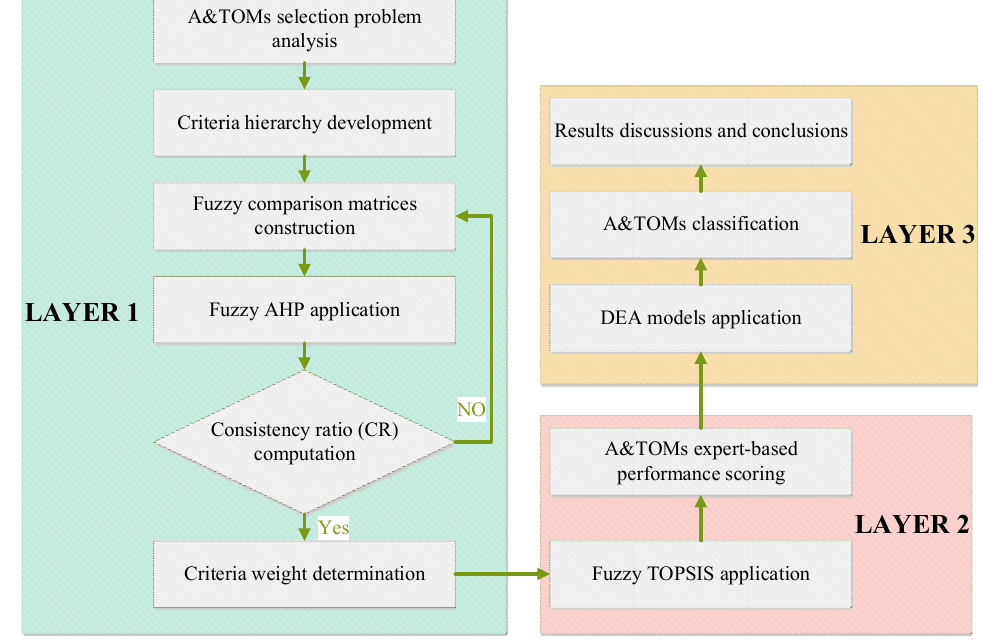
Figure 1. Methodology flow chart. Figure 1.